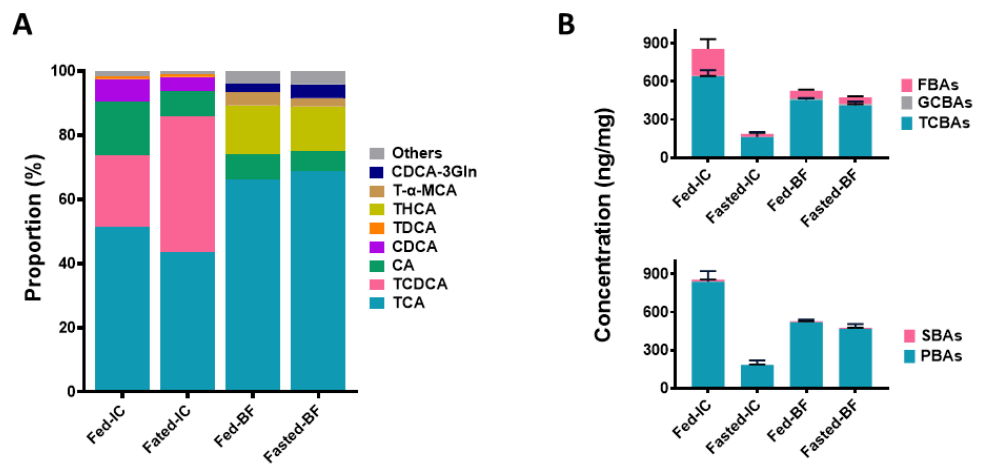
Figure 3. Compositions of BA profiles in large yellow croaker ( Larimichthys crocea ). ( A ) The amounts of the top five BAs are presented as a proportion of the total pool. ( B ) The classification and statistics of BAs in different groups. Ethanolic extracts of ICs with regular feeding (Fed-ICs) and after a 24 h fast (Fasted-ICs) and bile fluids with regular feeding (Fed-BFs) and after a 24 h fast (Fasted-BFs) were analyzed by UHPLC‒MS/MS. Data are presented as the mean ± S.E.M.; n = 5. TCA, taurocholic